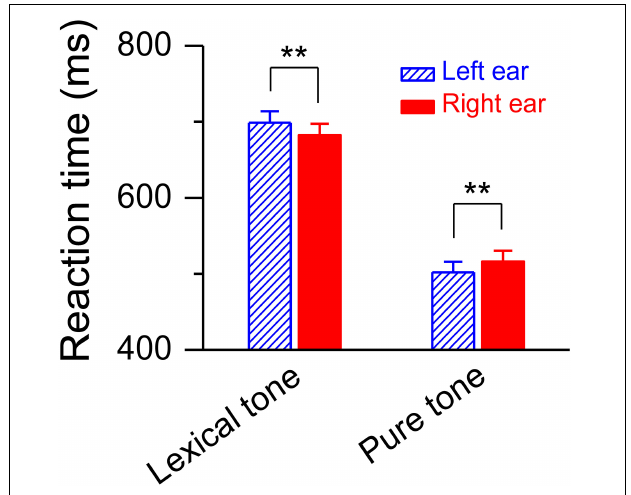
FIGURE 4 | Reaction time for dichotic listening judgment. Statistics showing shorter reaction time to the deviant lexical tone, but longer reaction time to the deviant pure tone, in the right ear than in the left ear during the dichotic listening judgment task. Asterisks indicate a statistically significant difference. ∗∗ P < 0.01. Vertical lines represent one standard